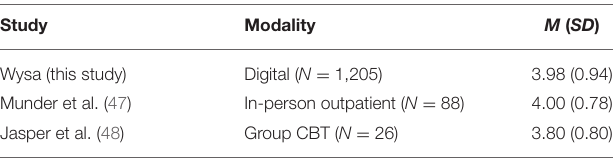
TABLE 3 | Comparison of Working Alliance Inventory-Short Revised bond subscale scores across therapeutic modalities. Study